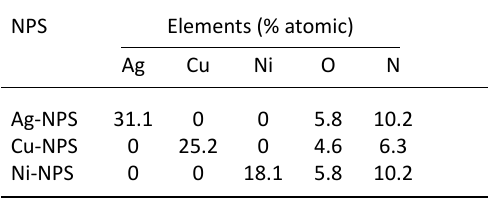
table 1. EDS analysis of Ag-NPS, CU-NPS, Ni-NPS